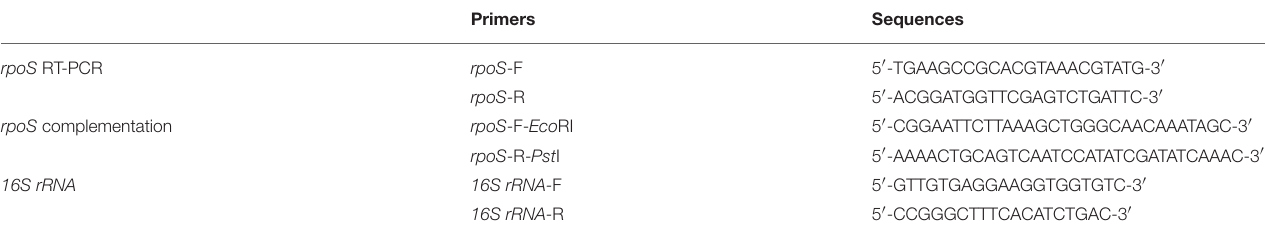
TABLE 1 | Primers used in RT-PCR analysis for rpoS